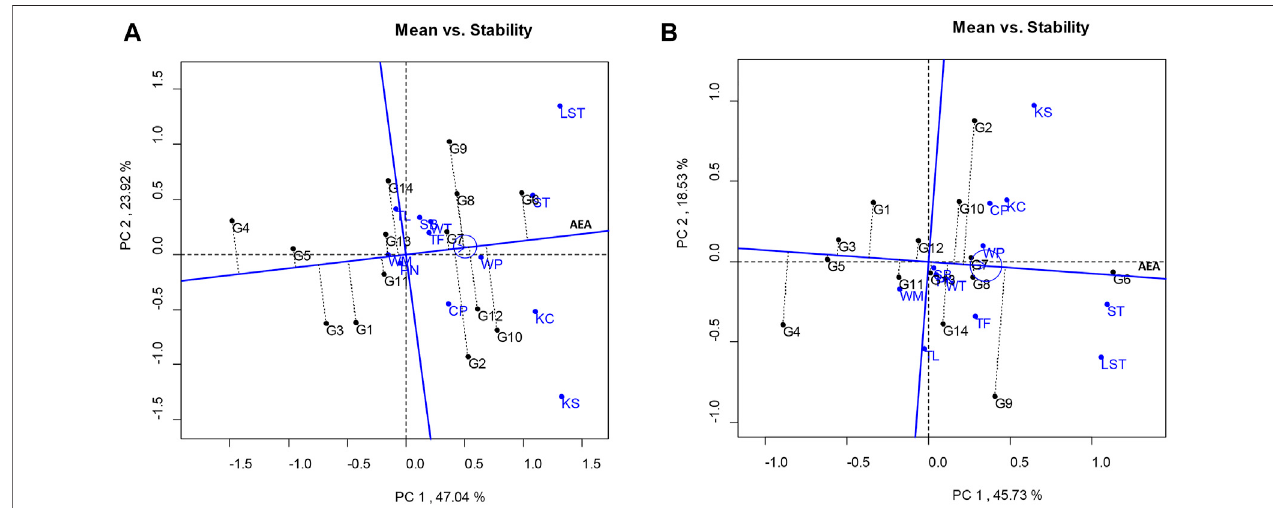
FIGURE1| AverageenvironmentcoordinationviewsoftheGGEbiplotbasedonlocation-focusedscalingofmeanperformanceandstabilityofgenotypes. (A) Pod yield. (B) Seed yield.